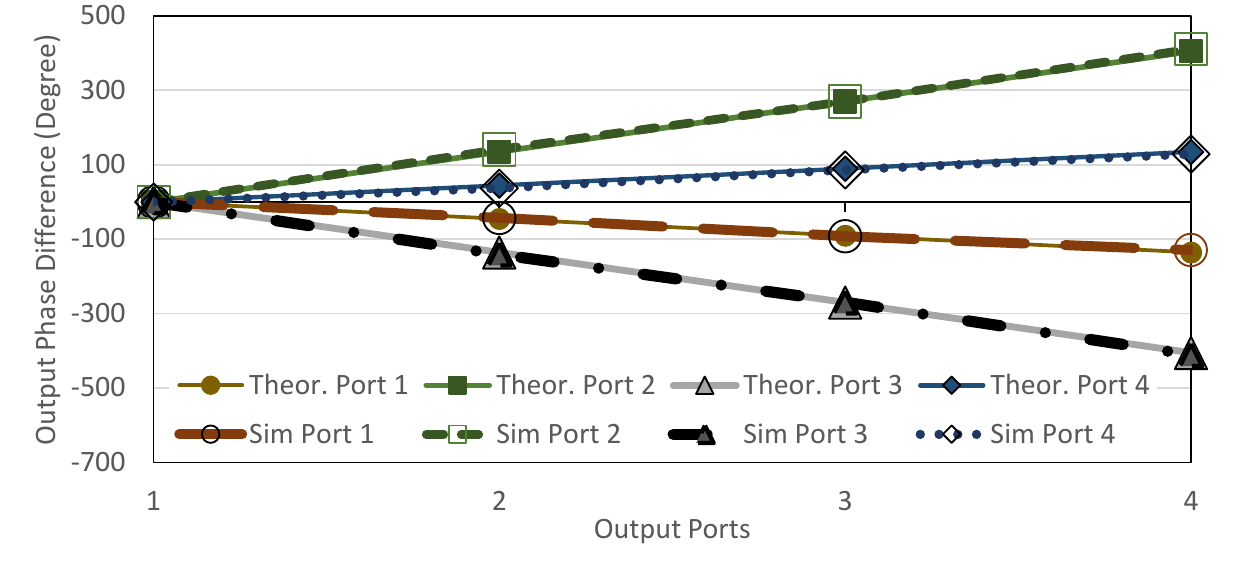
Figure 18. Transmission amplitude, S ij , of the proposed BM.